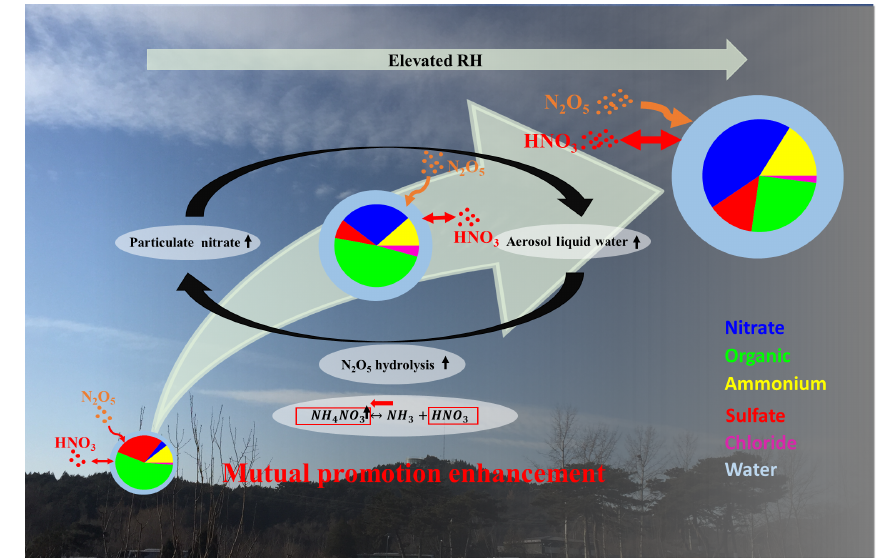
Figure 9. The scheme of the mutual-promotion effect between aerosol liquid water and particulate